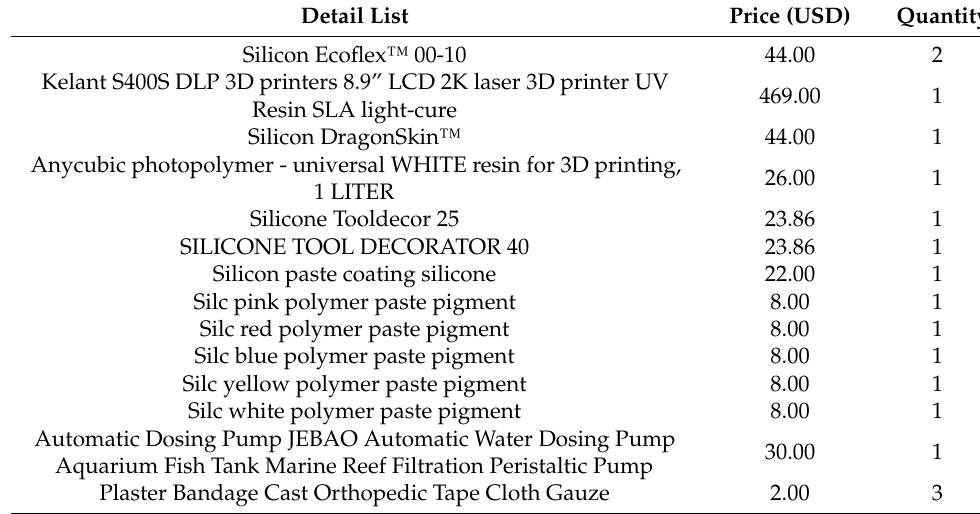
Table 1. Cost analysis information.